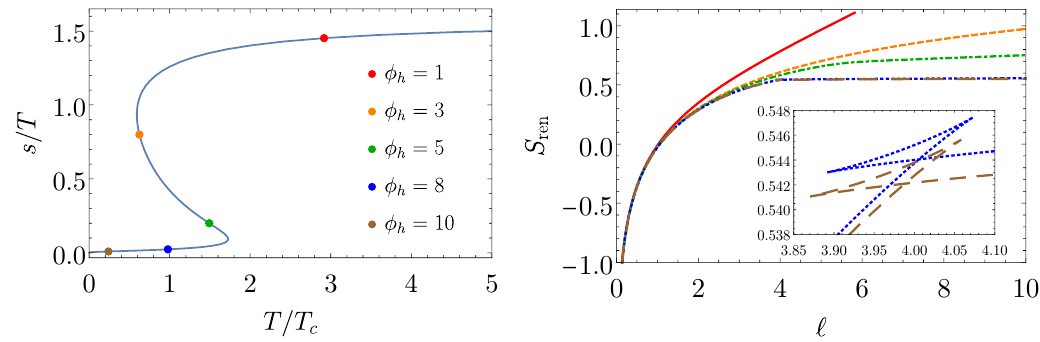
Figure 8 . Left panel: entropy density over temperature for first order phase transition ( α = 0 . 32 ). Dots: horizon value of scalar field, φ h = 1 , 3 , 5 , 8 , 10 . Right panel: EE computed using (5.16) for different black brane solutions as function of interval ‘ . Colors correspond to solutions marked with points in left